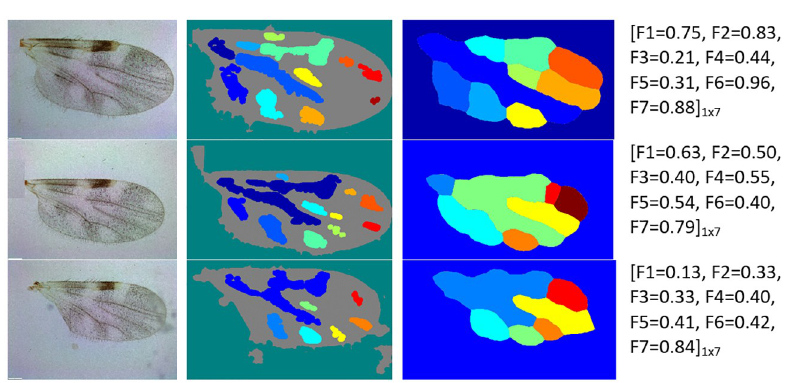
Fig 5. Performance of the proposed method on C. obsoletus species samples. From left to right column: original wing image, particle detection, segmentation of zones of interest through the watershed method, and the final feature vector output